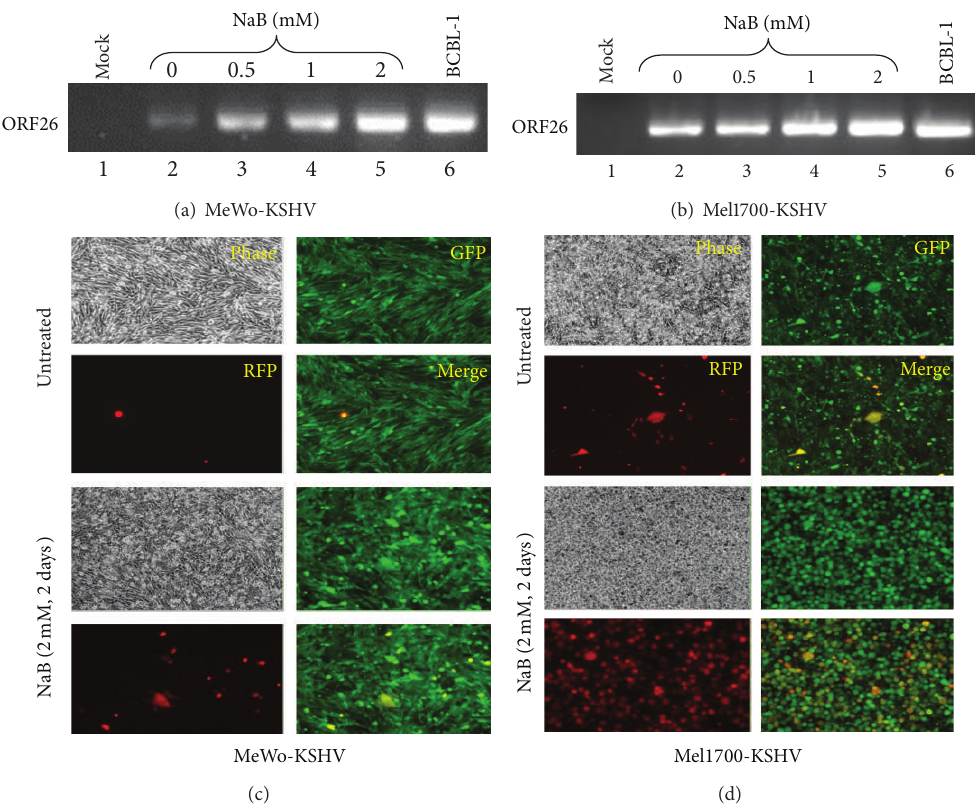
Figure 2: Differential induction of viral lytic cycle in skin cells reveals cell line-specific correlates of latency. (a) and (b): Total DNA was extracted from 5 × 10 5 rKSHV.219-infected MeWo-KSHV cells (a) or Mel1700-KSHV cells (b) either mock-treated or treated with increasing concentrations of NaB, as indicated. An equal amount of normalized viral DNA was then used for PCR amplification of the virus genome using ORF26-specific primers (Table S1). Approximately 10ng of DNA from KSHV-infected BCBL-1 cells was used as a positive control. (c) and (d): Representative phase, GFP, RFP, and color-merged images of infected MeWo-KSHV (c) or Mel1700-KSHV cells (d) either untreated or treated with 2 mM NaB for two